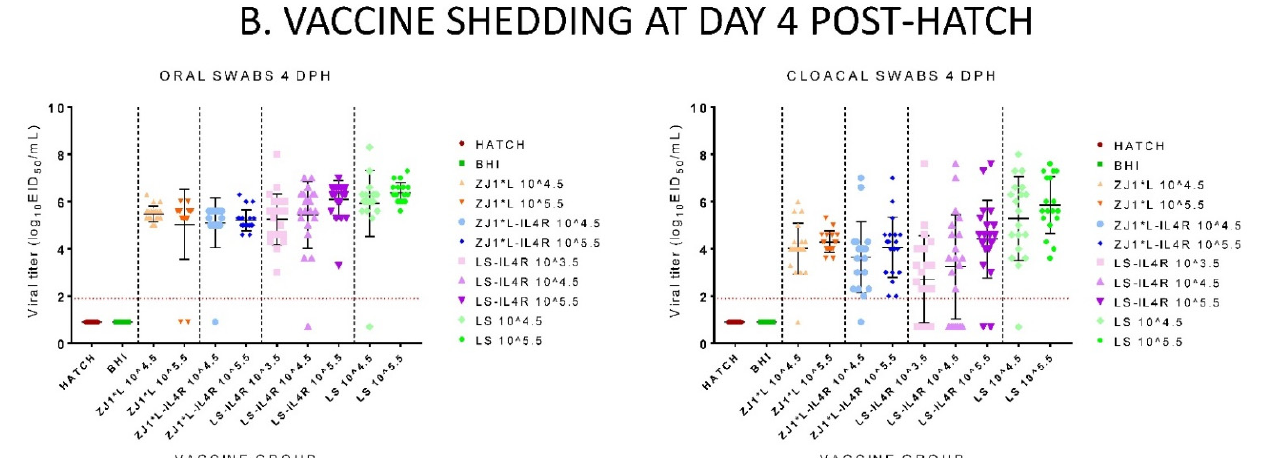
Figure 2. Mean post-hatch vaccine shedding from chickens hatched from commercial eggs inoculated at 18 days of embry- onation with experimental in ovo vaccines. Each data point represents one bird and NDV titers detected in oropharyngeal (OP) and cloacal (CL) swabs at different days post-hatch (DPH). Shedding is presented separately for 2 days post-hatch ( A ) and 4 days post-hatch ( B ). Bars represent standard deviations of the mean. All swabs from which virus was not detected were given a numeric value of 1 log below the limit of detection for each of the respective viruses. The limit of detection of rRT-PCR is presented as a horizontal dotted line (the lowest limit is used). Group abbreviations: HATCH—eggs not inoculated; BHI—eggs inoculated with BHI; rHVT-ND—eggs inoculated with recombinant HVT vaccine; ZJ1*L—eggs inoculated with the recombinant ZJ1*L virus whose cleavage site was modified to be of low virulence; ZJ1*L-IL4R—eggs inoculated with the recombinant low virulent ZJ1*L with the interleukin-4 gene inserted in reverse orientation; LS—eggs inoculated with the LaSota strain; LS-IL4R—eggs inoculated with the recombinant LaSota virus with the interleukin-4 gene inserted in reverse orientation. The virus dose that the eggs in each group received is represented as a number after the group name in EID 50 /per egg.